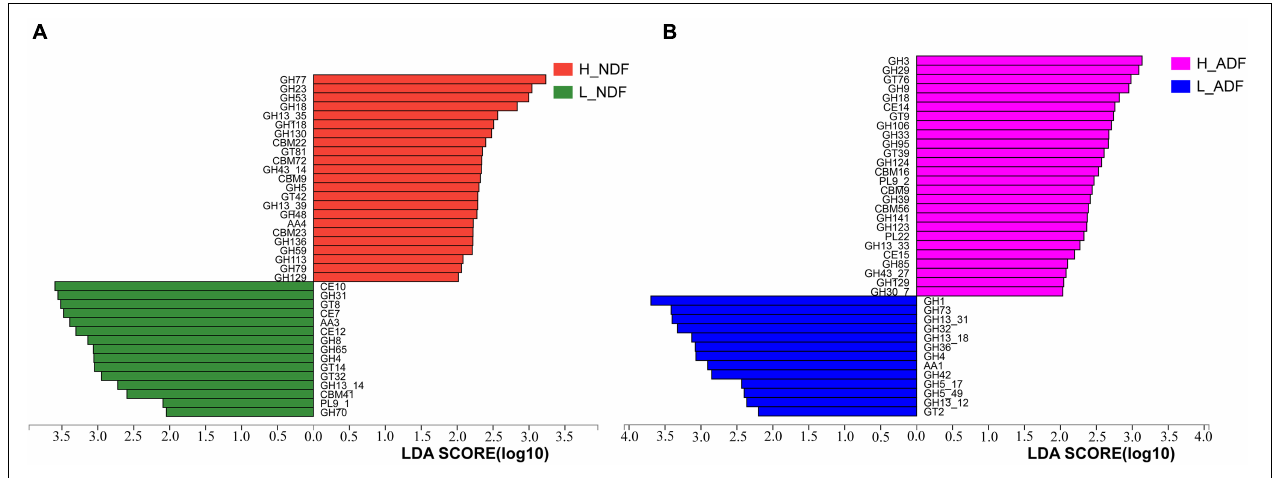
FIGURE 6 | LEfSe analysis of CAZymes between H_NDF and L_NDF groups (A) and H_ADF and L_ADF groups (B) , respectively. CAZy families with a linear discriminant analysis (LDA) score > 2 were